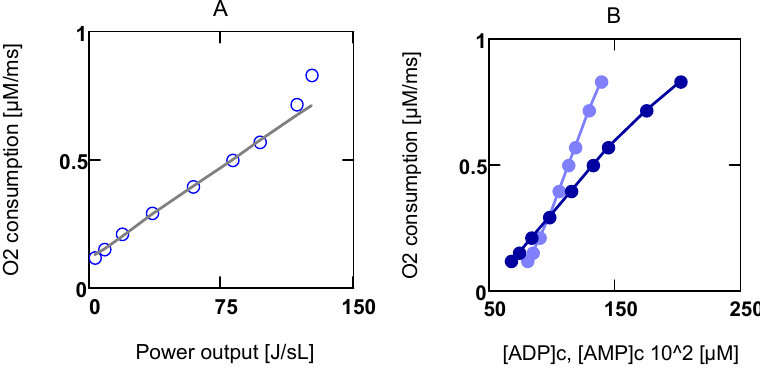
Figure 6. O consumption versus power output of contraction. A : (circles) results from 2 simulation; (line) regression line: 3 J P      , r = 0.9993 (without the 4.7446 10 0.116 O W 2 top two points); B : (light-blue) O consumption versus [ADP] 2 consumption versus [AMP] . SIM c GlOx